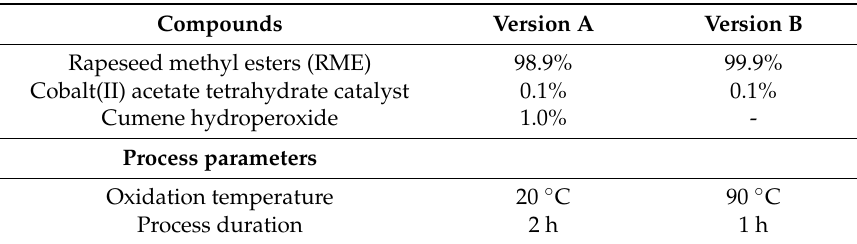
Table 2. Bio-agent types.